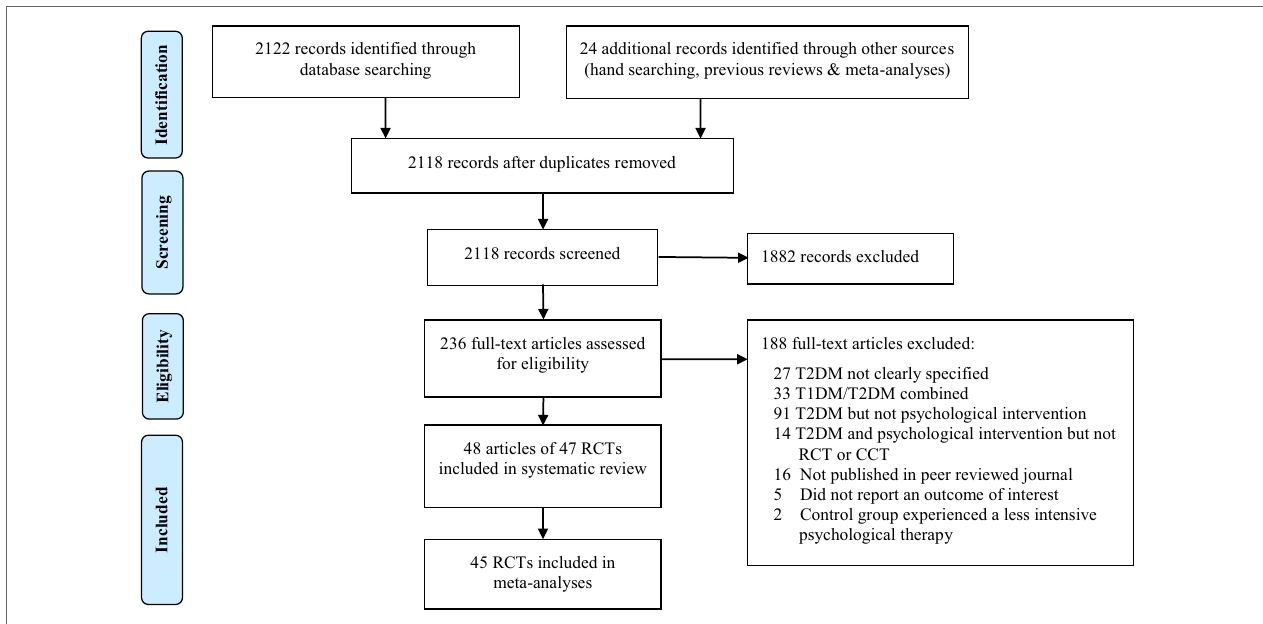
FiGURe 1 | PRiSMA flow diagram